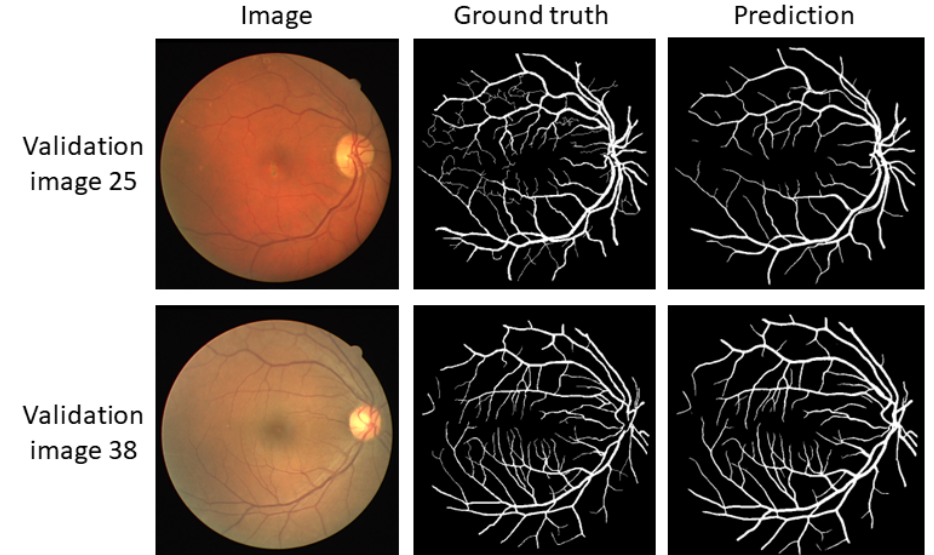
Figure 7. Two validation images, its real mask and the ConvMixer